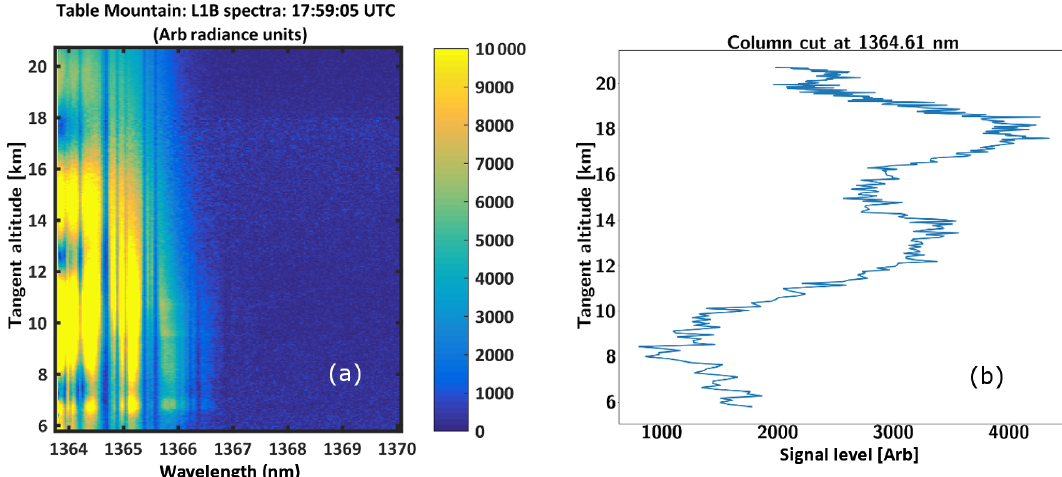
Figure 14. Example level 1B spectral image (a) and a column cut taken at a wavelength of 1364.61nm (b) .